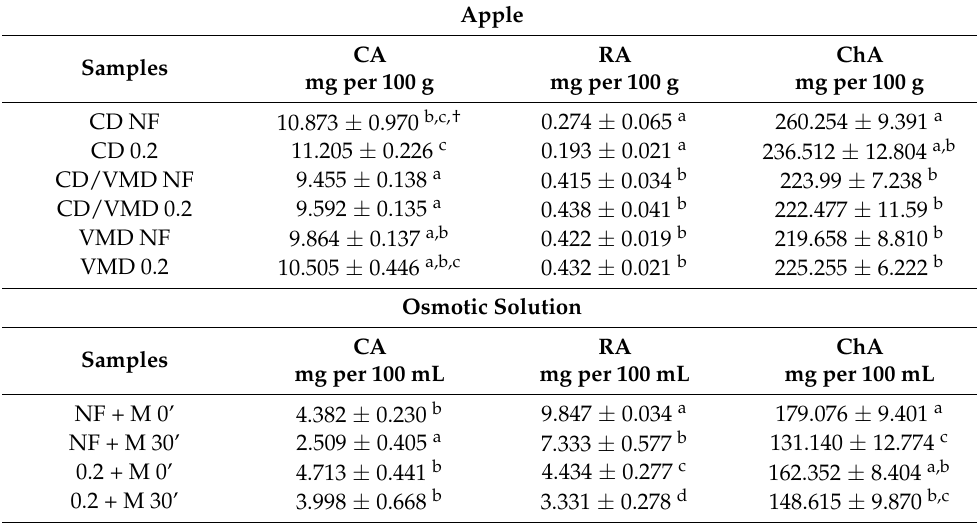
Table 4. Caffeic acid (CA), Rosmarinic acid (RA) and Chlorogenic acid (ChA) in the osmotic solutions before and after osmotic dehydration as well as in the material after drying using different methods.